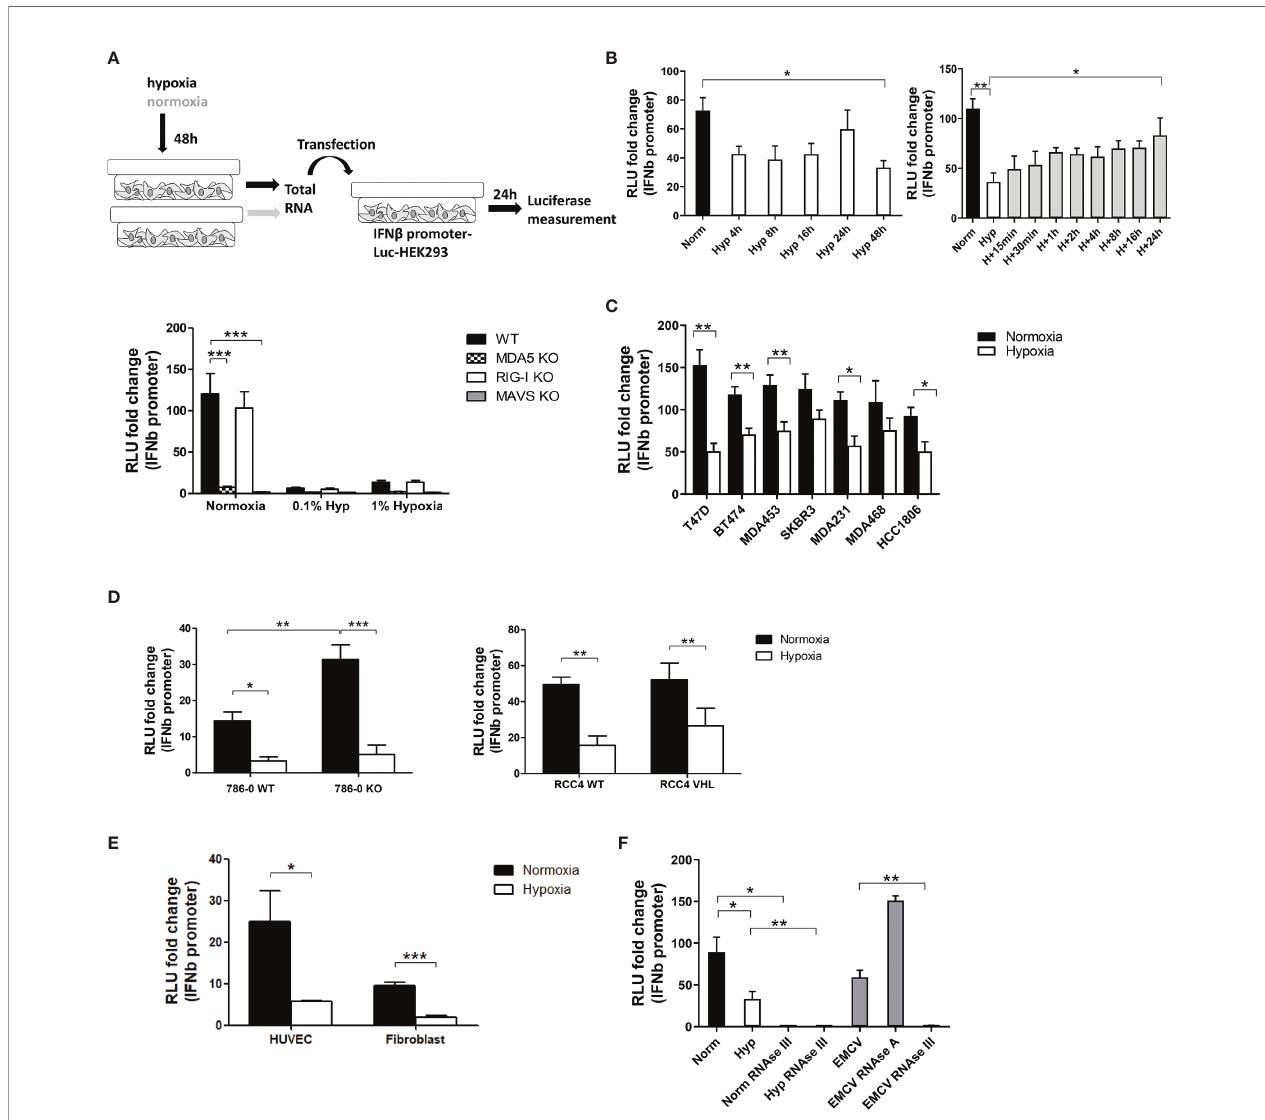
FIGURE 1 | Hypoxia decreased IFN b promoter stimulation. (A) An outline of the experiment is shown (top, please see text for detail). IFN b promoter reporter cells of the indicated genotypes were transfected with total RNA extracted from MCF7 cells exposed for 48h to normoxia, 1% hypoxia and 0.1% hypoxia. 24h after transfection, reporter cells were lysed and fi re fl y luciferase activity was determined (bar charts; RLU, relative light units). Data from control cells treated with transfection reagent only were used to calculate RLU fold changes after RNA transfection (n=10). (B) IFN b promoter stimulation time course using RNA from MCF7 cells exposed to normoxia or 0.1% hypoxia for 4h, 8h, 16h, 24h and 48h (left panel, n=3), and reoxygenation for 15min, 30min, 1h, 2h, 4h, 8h, 16h and 24h after 48h in 0.1% hypoxia (right panel, n=3). (C) IFN b promoter stimulation using RNA from a panel of breast cancer cell lines exposed to normoxia or 0.1% hypoxia for 48h. (D) IFN b promoter stimulation using RNA from 786-0 WT or 786-0 HIF2 a KO cells (786-0 KO, left panel, n=3), and RCC4 EV or RCC4 VHL (right panel, n=3) exposed to normoxia or 0.1% hypoxia for 48h. (E) IFN b promoter stimulation using RNA from non cancerous cell lines exposed to normoxia or 0.1% hypoxia for 48h (n=3). (F) IFN b promoter stimulation using RNA from MCF7 cells treated with RNAse A or RNAse III, and EMCV dsRNA as positive control (n=3). Number of replicates indicate biological replicates and data is shown as mean ± SEM. *p < 0.05, **p < 0.01, ***p <